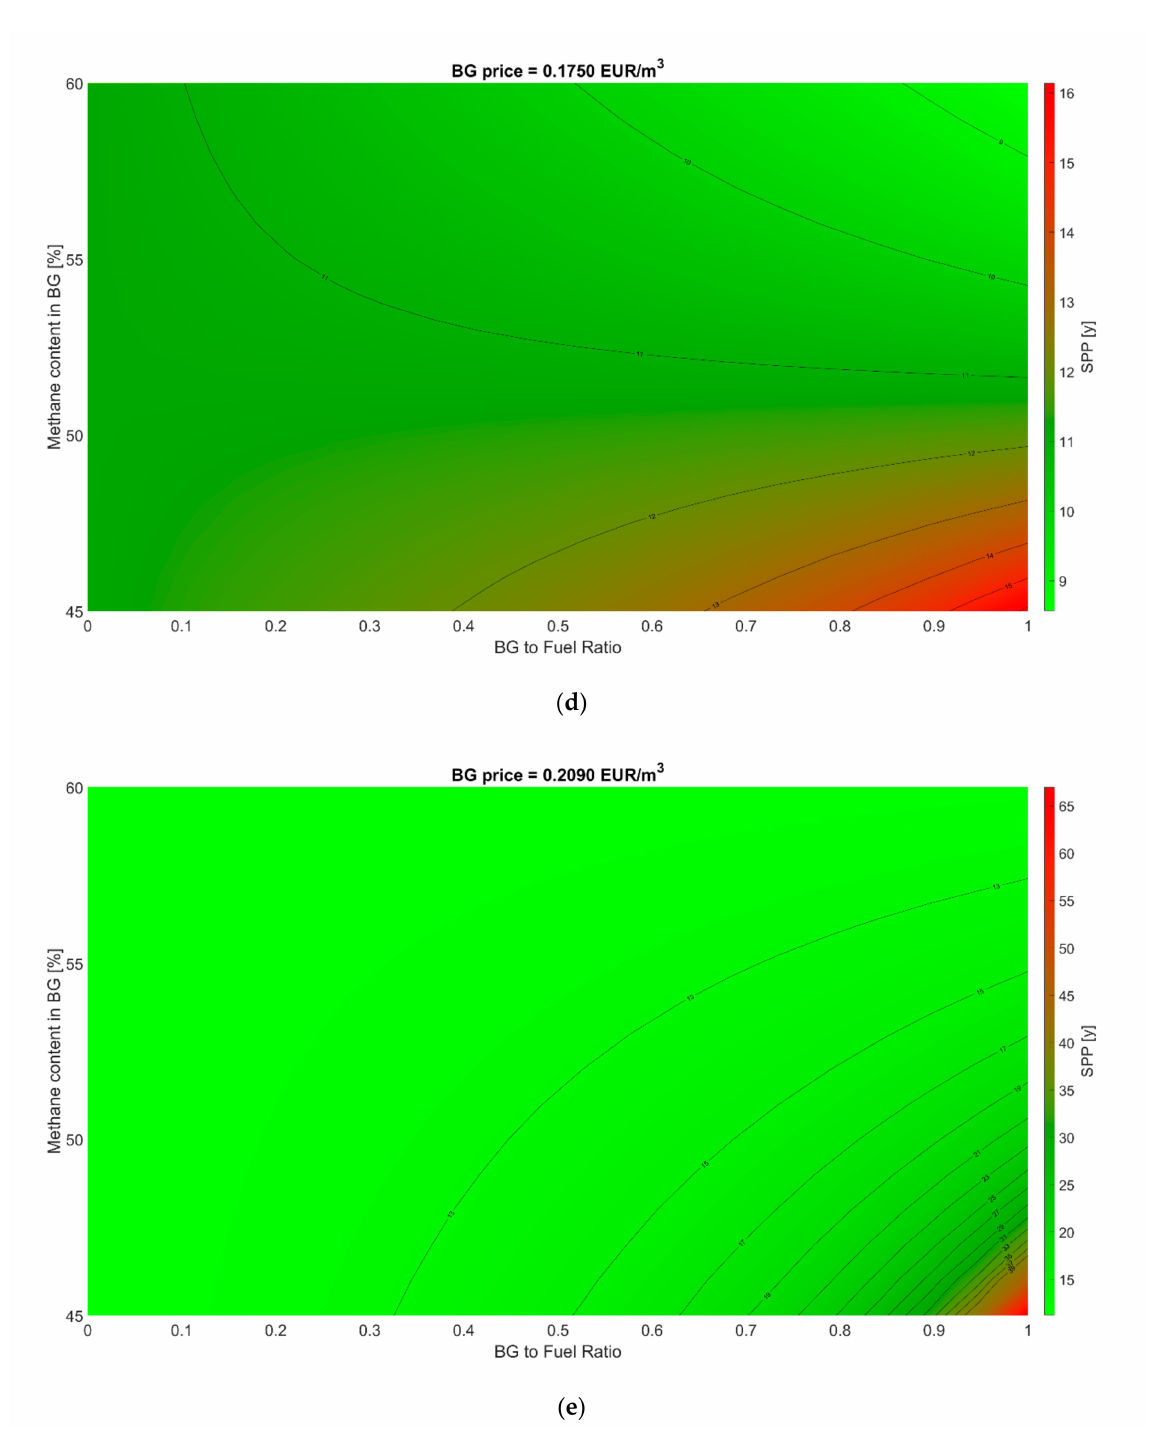
Figure 10. SPP for scenario A of milk drying unit as a function of biogas-to-fuel ratio, methane content in biogas, and biogas price—0.073 EUR / m 3 ( a ), 0.107 EUR / m 3 ( b ), 0.141 EUR / m 3 ( c ), 0.175 EUR / m 3 ( d ), and 0.209 EUR / m 3 ( e